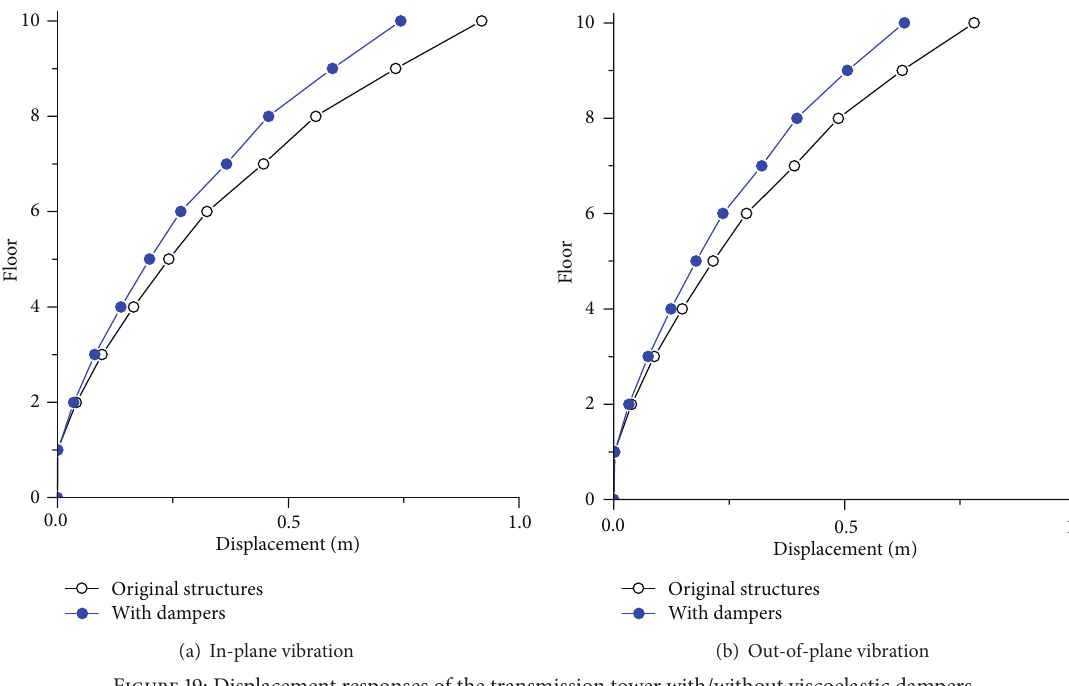
Figure 19: Displacement responses of the transmission tower with/without viscoelastic dampers.